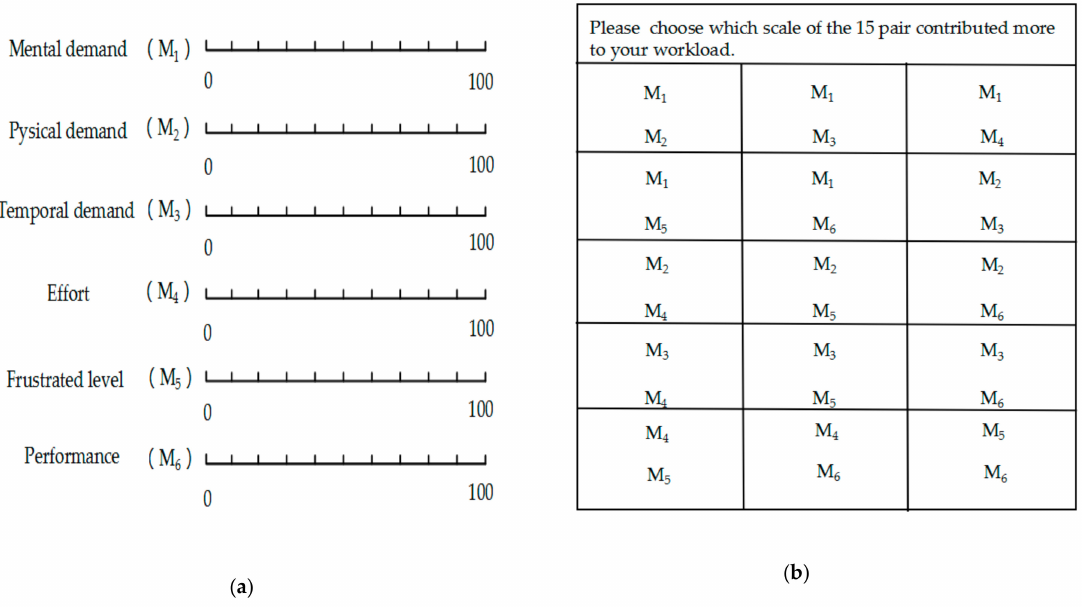
Figure 3. The fatigue value obtains from the scale of NASA-TLX: ( a ) The six aspects; ( b ) The fifteen pairs regarding the six